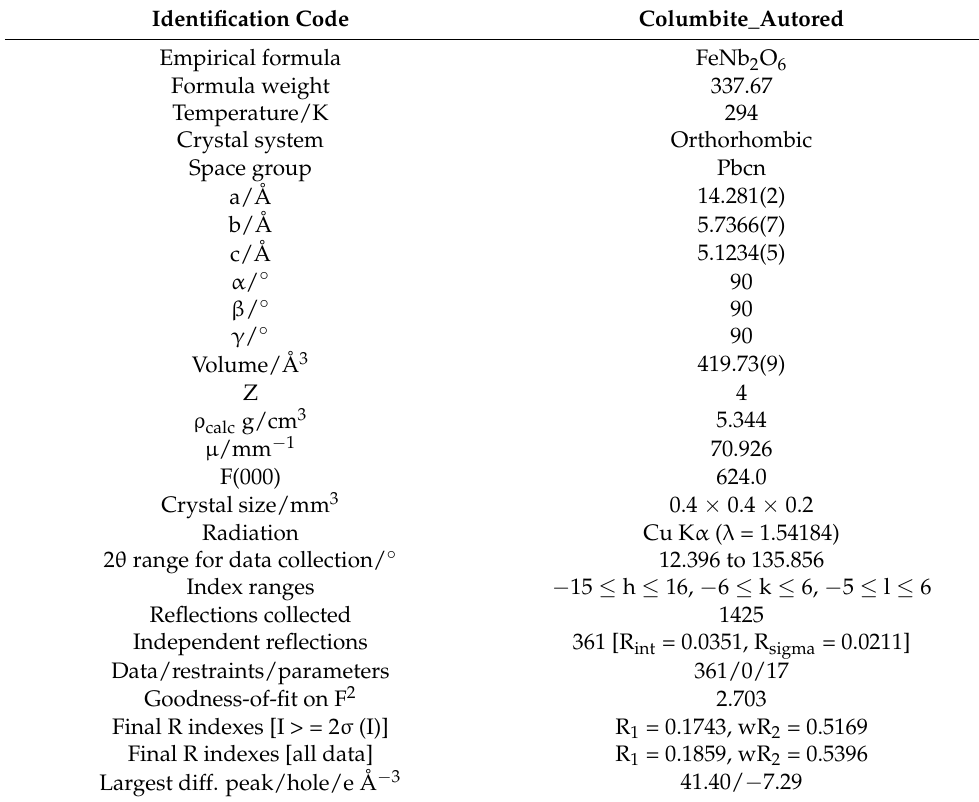
Table A2. Crystal data and structure refinement for Columbite_autored.